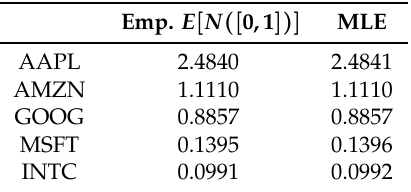
Table 3. Expected number of arrivals on a unit interval using estimated parameters from an MLE method is compared against the empirical